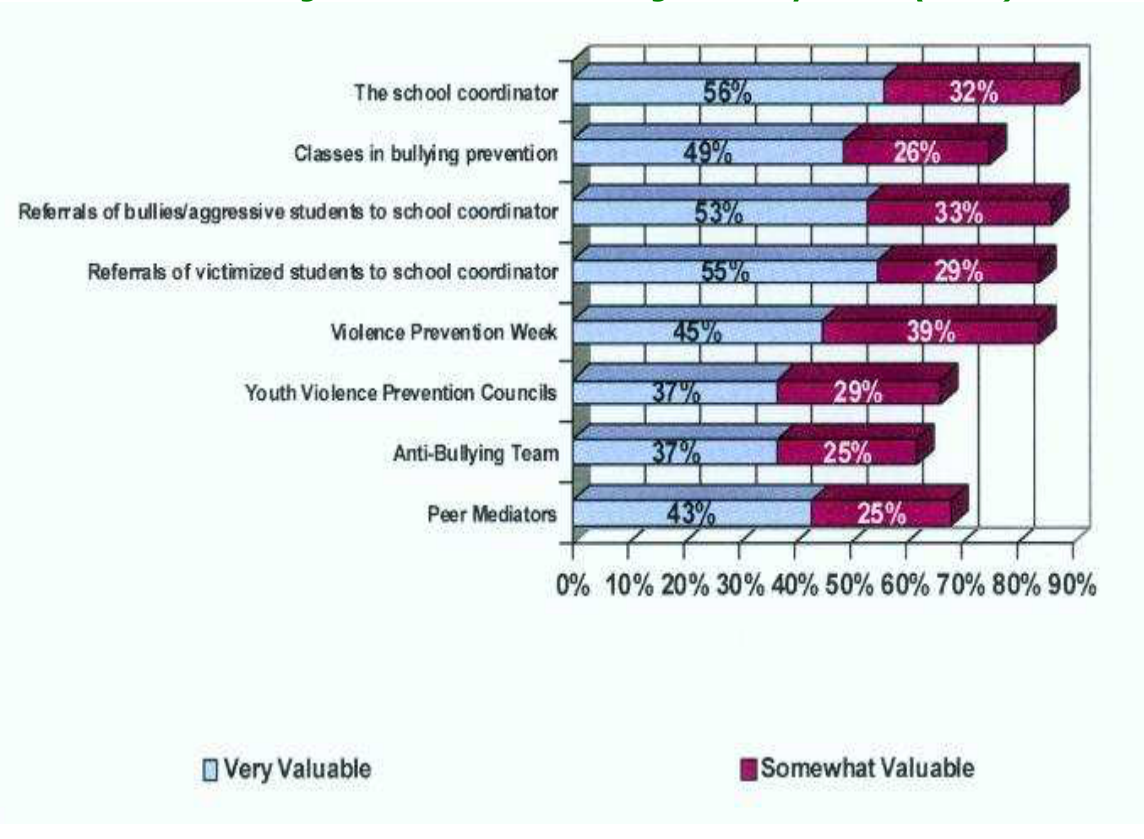
Teacher Ratings of Kids Win School Program Components